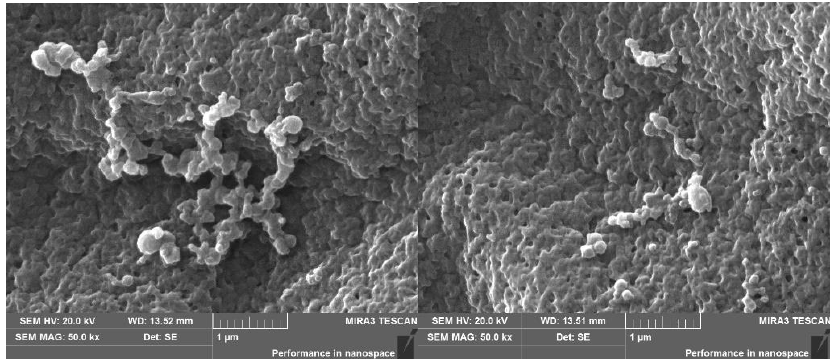
Figure 2. SEM images of the immobilized bacterium in PVA